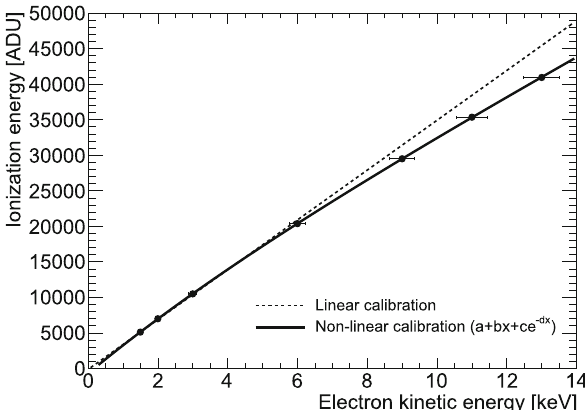
Fig. 6 Electron calibration. The dashed line represents a linear cal- ibration passing through the first data point and having an offset of − 117 ADU. The solid line is a fit with a first order polynomial function plus a decreasing exponential function. Error bars are drawn in X and Y but they are hardly visible in